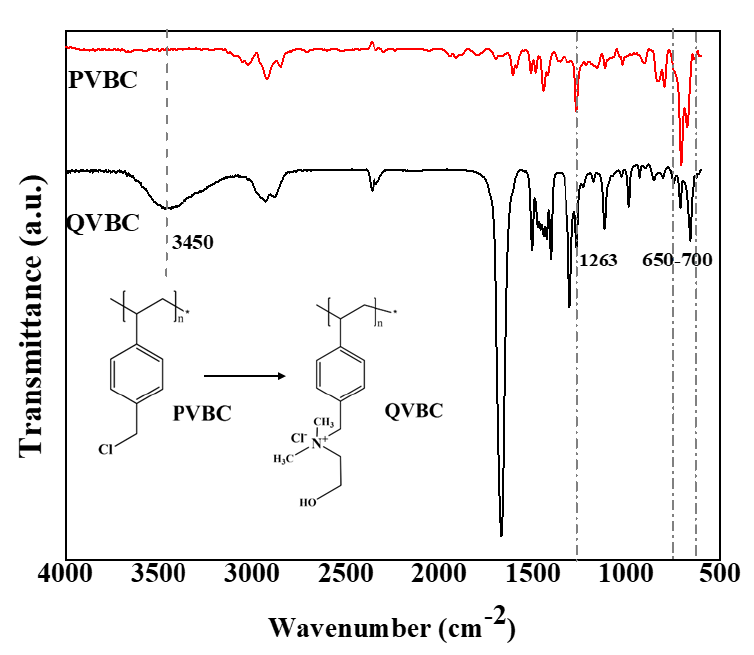
Figure 6. FTIR spectra of PVBC (poly vinylbenzyl chloride) and positively quaternized poly vinylbenzyl chloride (QVBC).